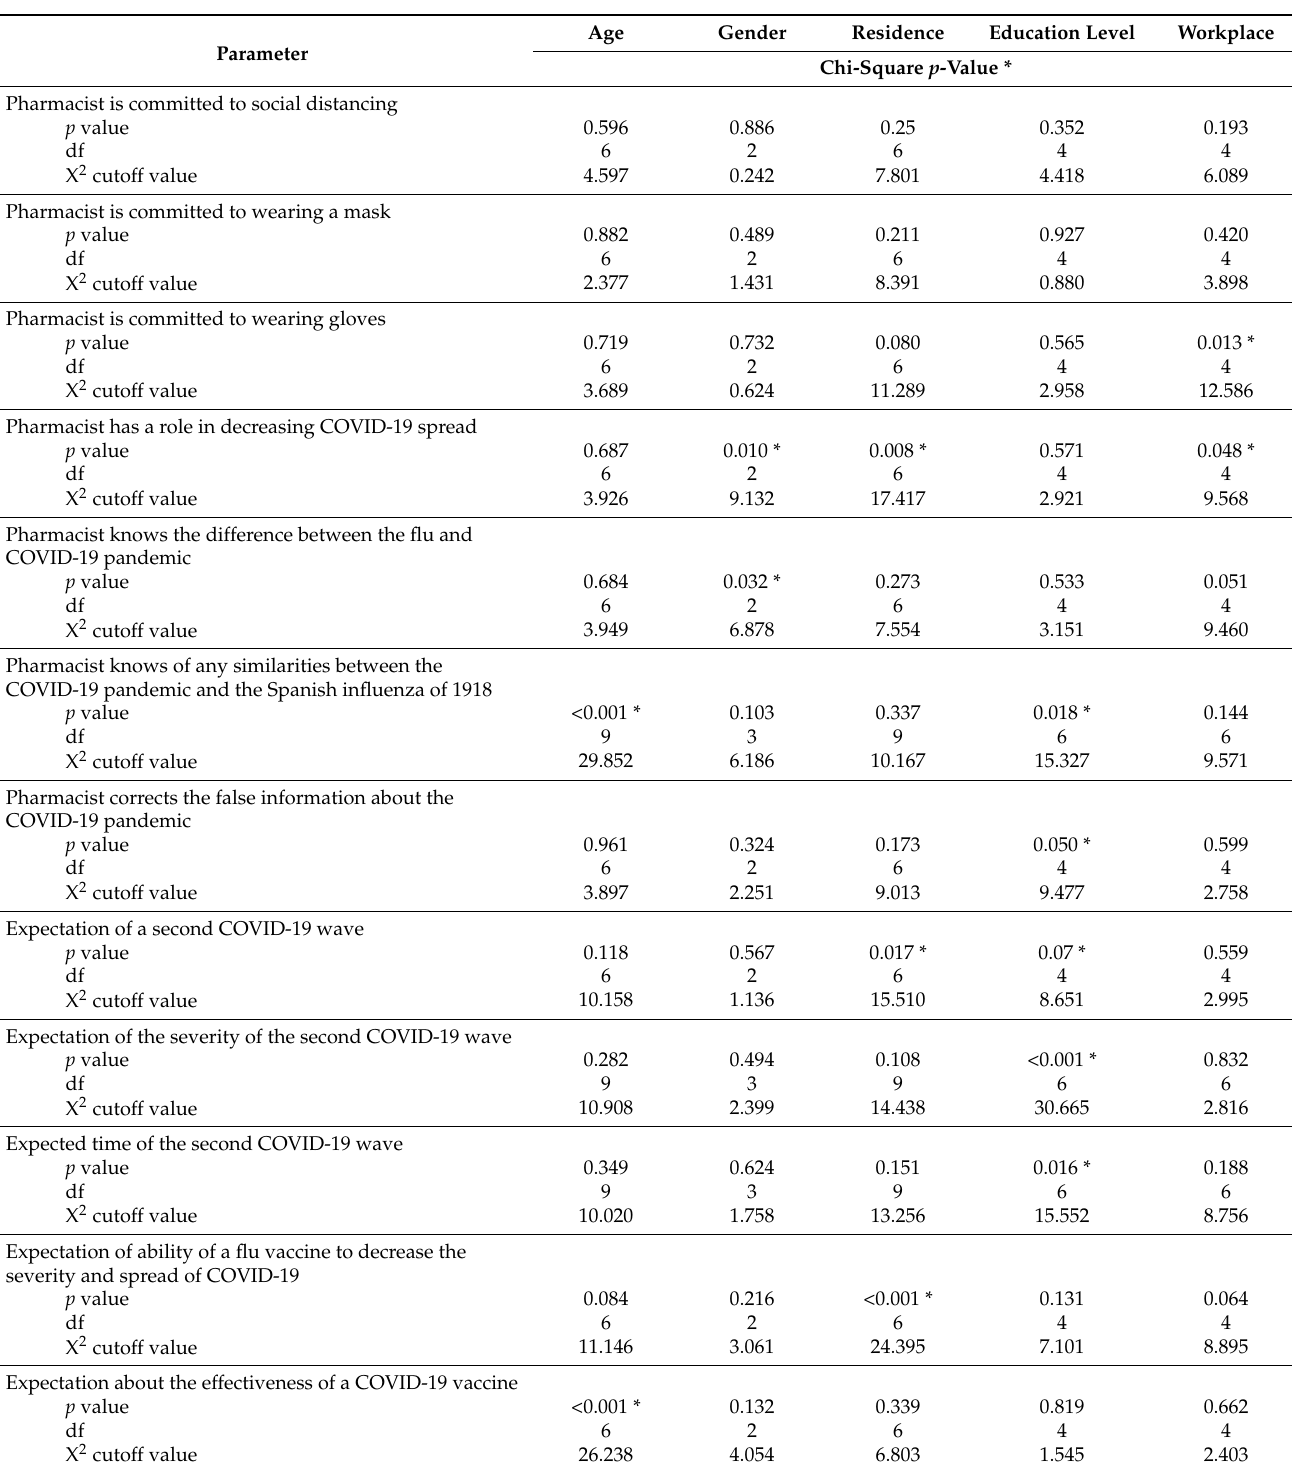
Table 4. Association between pharmacists’ characteristics and their knowledge, attitudes, practices, and expectations towards the COVID-19 pandemic, ( N =